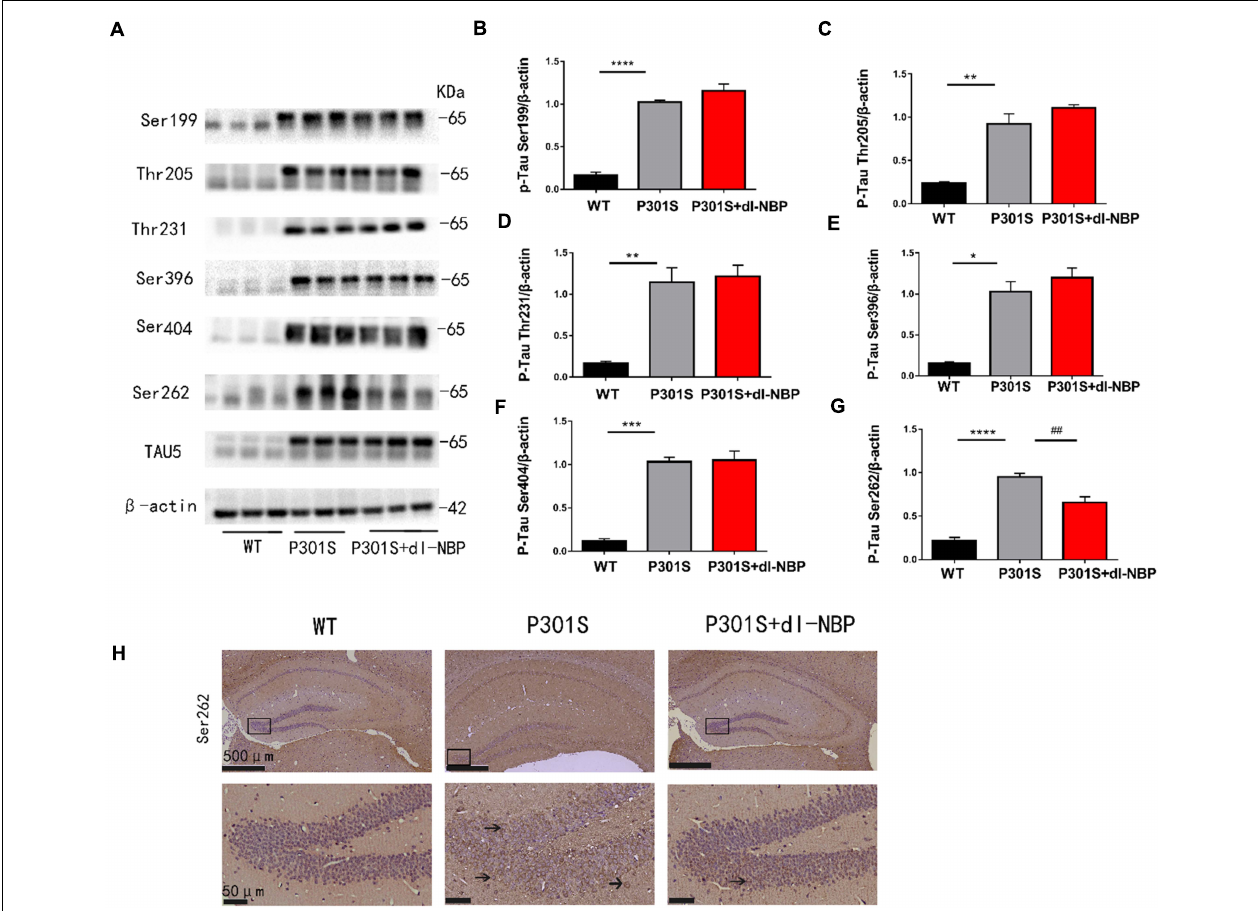
FIGURE 2 | dl-NBP treatment reduced hyperphosphorylation of tau at Ser262 in P301S mice. (A) Western blot analysis of phosphorylated tau at residues Ser396, Ser404, Ser199, Ser262, Thr231, and Thr205 in the brains. β -Actin served as a loading control. (B–G) Quantitative analysis of tau phosphorylation levels at the Thr205, Ser396, Ser404, Ser199, Ser262, and Thr231 sites. All results are presented as mean ± SEM ( n = 3). * P < 0.05, ** P < 0.01, *** P < 0.001, **** P < 0.0001, WT mice vs. P301S mice; ## P < 0.01, P301S mice vs. P301S + dl-NBP mice. (H) Detection of tau phosphorylation in the hippocampi by immunohistochemistry with anti-phospho-tau (Ser262) (scale bars: upper panel—500 µ m, lower panel—50 µ